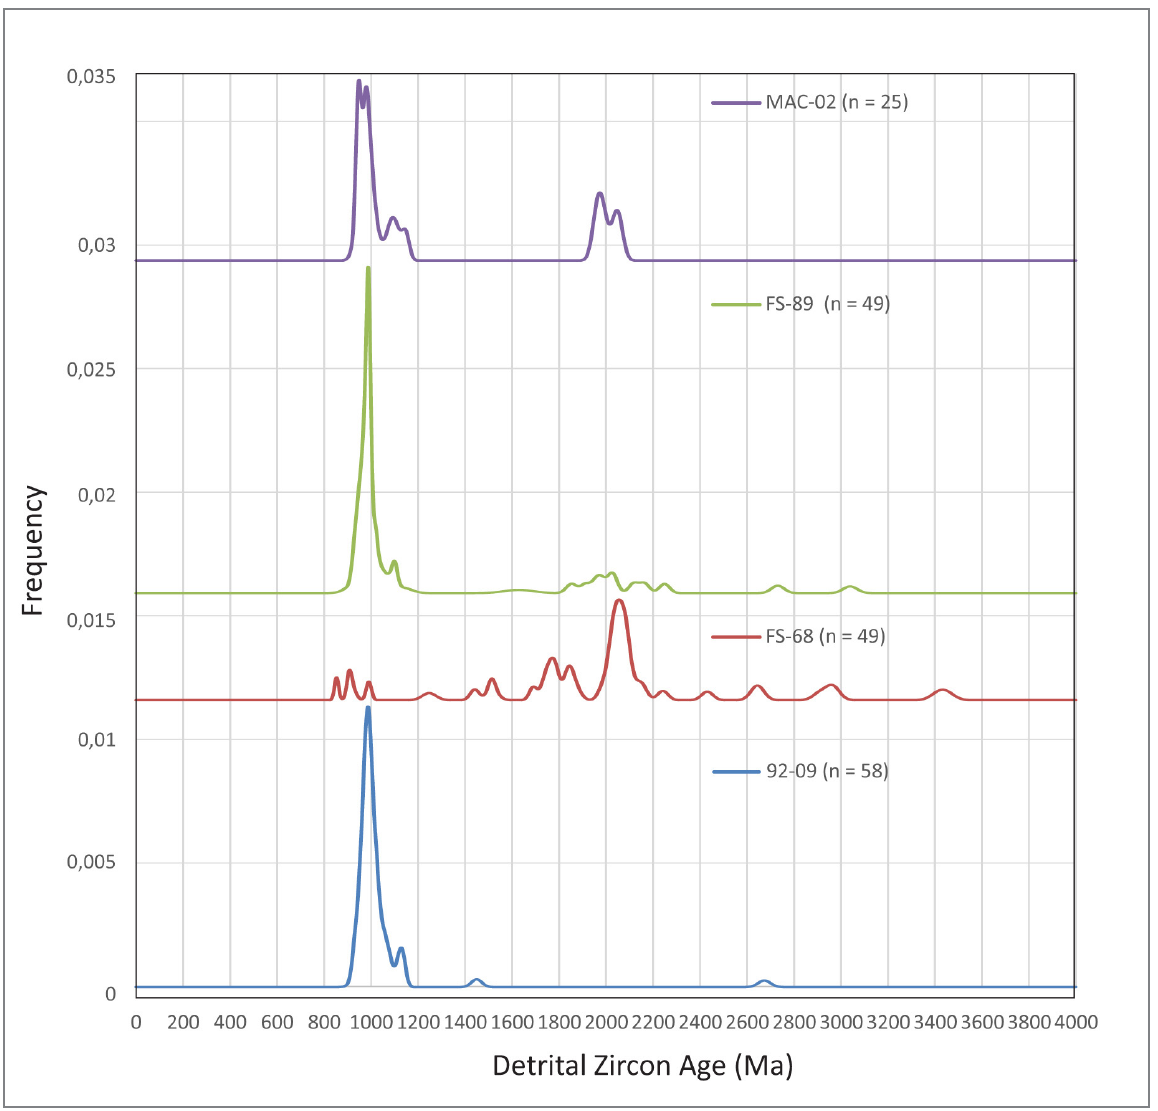
Figure 6 - Cumulative probability density distribution diagram of U-Pb detrital zircon ages from metasedimentary rocks of the Macururé Complex. Sources of data: MAC-02, this study; FS-89 and FS-68, Oliveira et al. (2015); 92-09, Van Schmus et al.